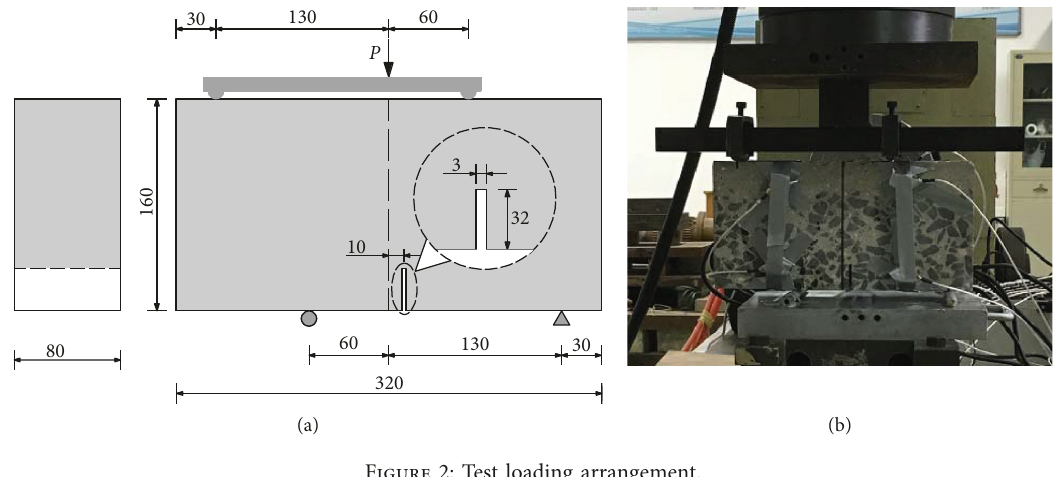
Figure 2: Test loading arrangement.